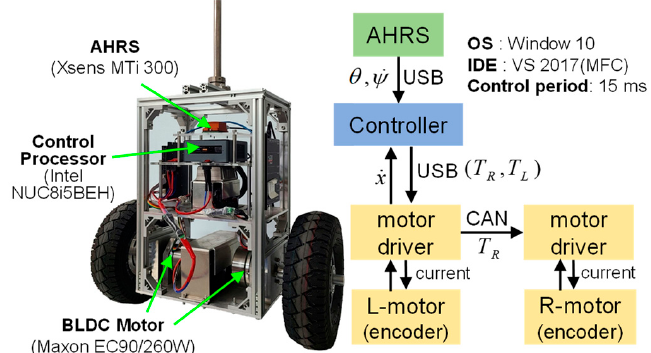
Figure 11. System architecture of the TWIP prototype.